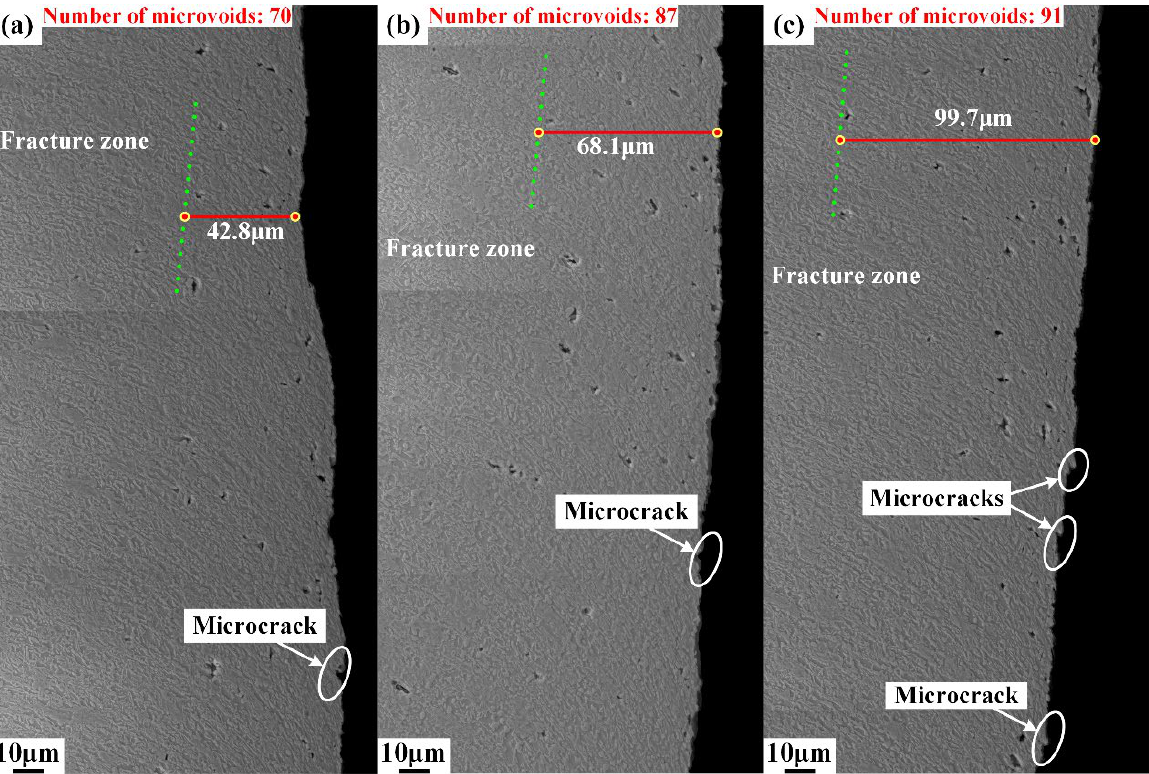
Figure 11. Microstructure of sheared edge in area III obtained under different shearing clearances: